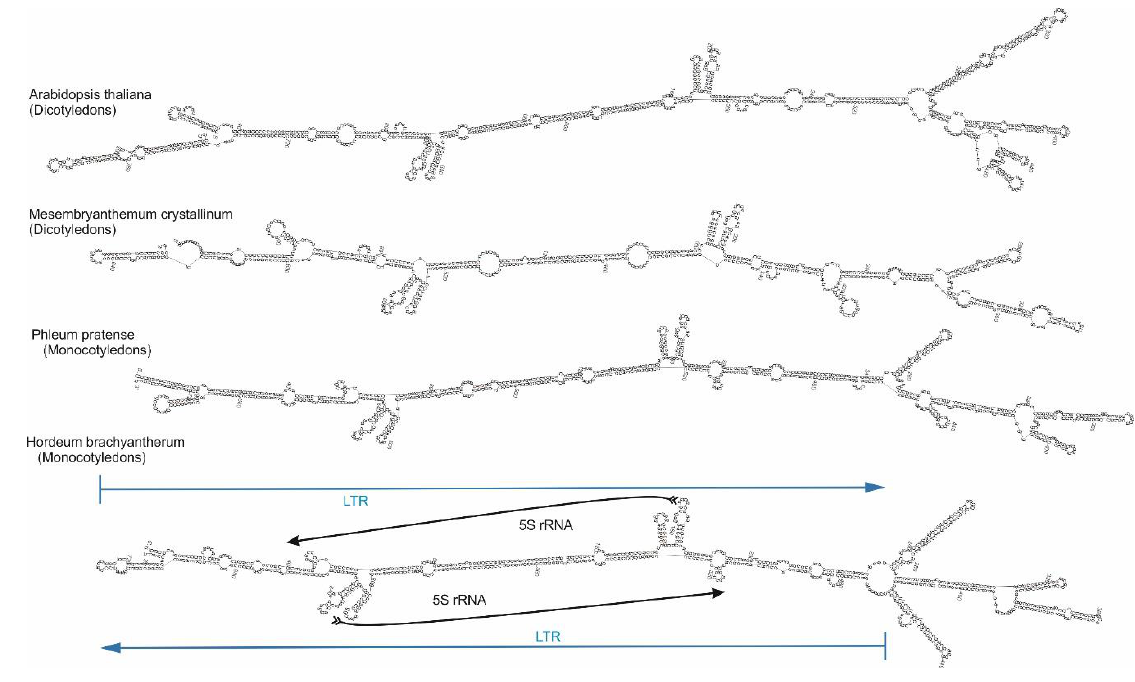
Figure 3. Super-hairpin structure predicted from the sequence of Cassandra elements. The whole Cassandra element forms a structure at folding, where both LTRs are complementary to each other with the complement region containing a 5S-rDNA sequence. The internal domain of the Cassandra element is also self-complementary, and the PBS and PPT domains are located near each other.